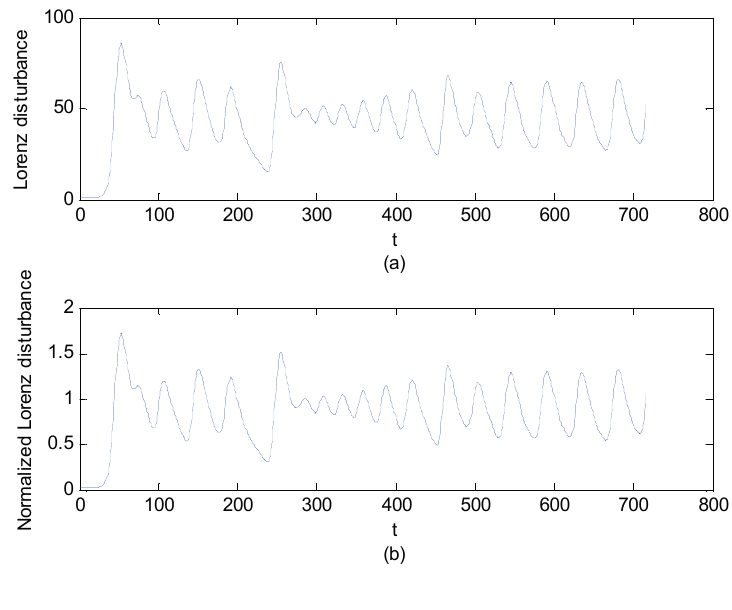
Figure 1. ( a ) The initial Lorenz disturbance defined by Formula (3). ( b ) The normalized Lorenz